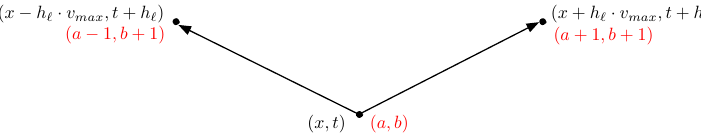
Figure 2. The two possible moves in a random walk. The coordinates in the local coordinate system are shown in red, while the Cartesian coordinates are shown in